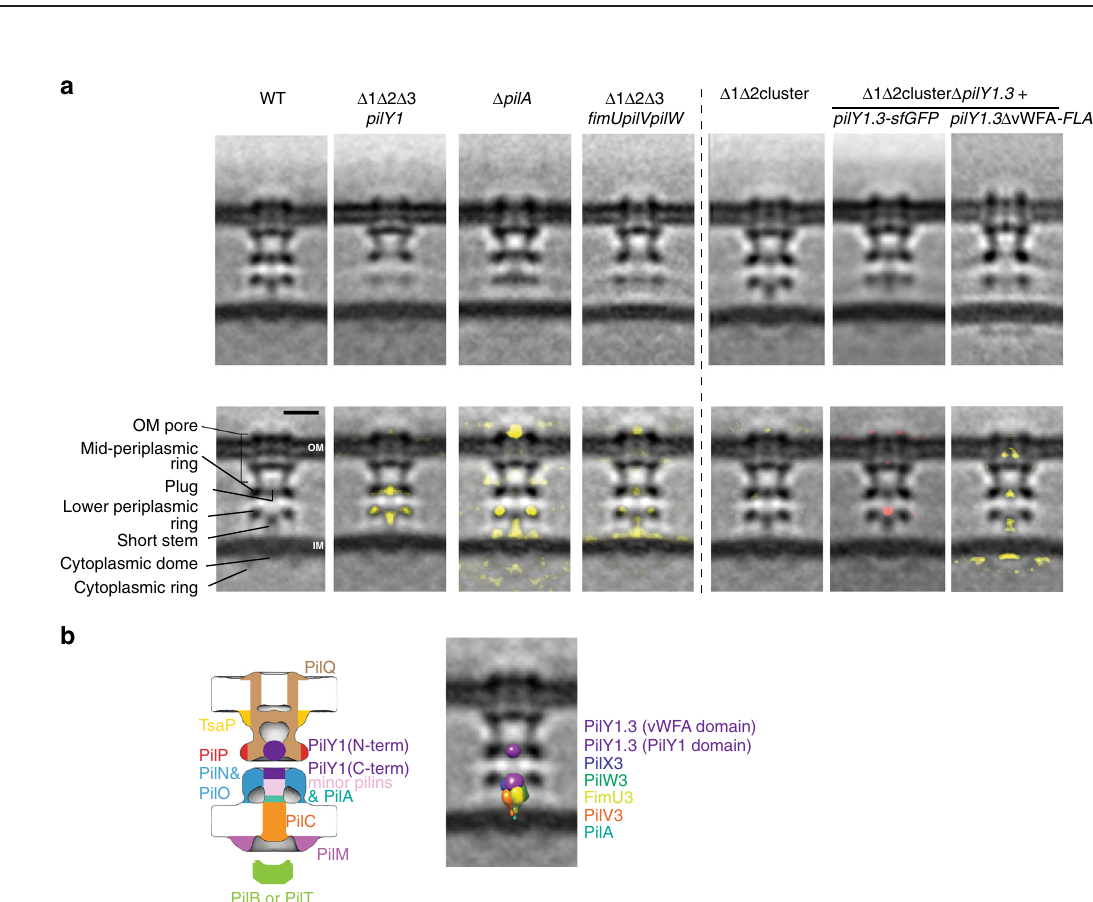
Fig. 3 Cluster_3 minor pilins and PilY1.3 interact. a T4aP-dependent motility assays for strains with tagged PilY1.3 or PilW3. Strains of the indicated genotypes were incubated 24 h. Scale bar, 1 mm. b Accumulation levels of PilY1.3-FLAG and GFP-FLAG. Protein from 3 × 10 8 cells were loaded per lane and blots probed with α -FLAG antibodies and α -LonD antibodies (loading control). c PilY1.3 and cluster_3 minor pilins interact. Pull-down experiments with α -FLAG matrix on cell extracts from strain of the indicated genotype expressing PilY1.3-FLAG or GFP-FLAG (negative control). Samples from two biological replicates and two negative controls were analyzed by LFQ-MS; mean iBAQ values and log2-fold enrichment in PilY1.3-FLAG samples compared to GFP- FLAG samples were calculated; enrichment for PilY1.3-FLAG was imputed. Columns represent mean of log2-fold enrichment ( n = 2); dots represent the corresponding data points; n.d., not detected in PilY1.3-FLAG samples. d , e Accumulation levels of PilY1.3-sfGFP and PilW3-sfGFP. Protein from 3 × 10 8 cells was loaded per lane and blots were probed with α -GFP antibodies and α -LonD antibodies (loading control). Gap between lanes indicate lanes that were deleted for presentation purposes. f PilY1.3-sfGFP and PilW3-sfGFP localize bipolarly in the presence of assembled T4aPM. Insets are enlargements of the boxed areas. Note that the PilW3-sfGFP clusters formed in the Δ pilQ strain were smaller and of lower intensity than in WT. N > 100 cells per strain; localization patterns in percentage indicated in schematics (bipolar, unipolar, diffuse (top to bottom)). Scale bars, 5 µ m. g PilY1.3-sfGFP and cluster_3 minor pilins interact. Pull-down experiments with α -GFP matrix and cell extracts of cells of the indicated genotype containing PilY1.3-sfGFP or GFP-FLAG (negative control). Samples were analyzed as in c ; enrichment was imputed for PilY1.3-sfGFP. h PilW3-sfGFP and cluster_3 proteins interact. Pull-down experiments with α -GFP matrix on cell extracts of the indicated genotype containing PilW3-sfGFP or GFP-FLAG (negative control). Samples were analyzed as in c ; enrichment was imputed for PilW3-sfGFP.